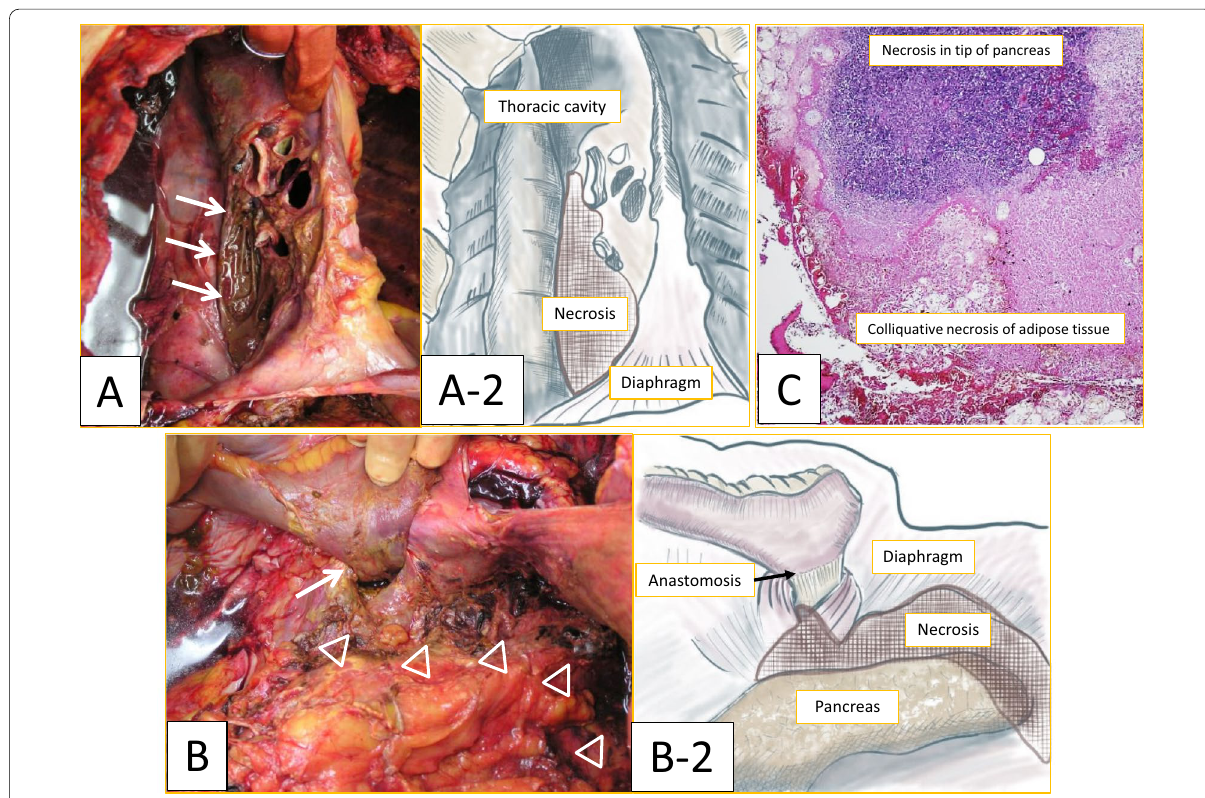
Fig. 3 Post-mortem findings. A Macroscopic finding of the right side of the mediastinum, necrosis is observed in the mediastinum. A-2 A schema of figure A. B Macroscopic finding of the posterior side of the anastomosis (arrow), the anastomotic site is intact, and continuous necrosis is observed around the pancreatic tail ( △ ) to the mediastinum. B-2 A schema of figure B. C Microscopically the surrounding adipose tissue of the pancreas showed colliquative necrosis. The inflammation was especially severe in the tail of the pancreas causing necrosis in the tip of the pancreatic tail